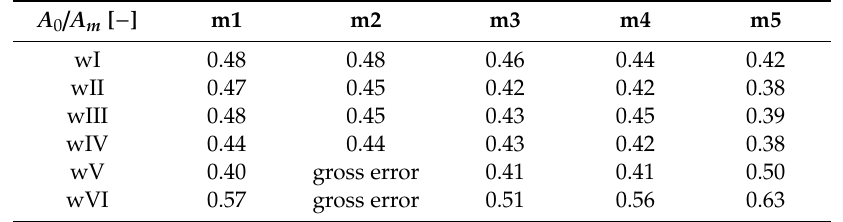
Table 6. Ratio of the wave amplitude reflected from the surface of the slab to the wave amplitude reflected from the metal plate.